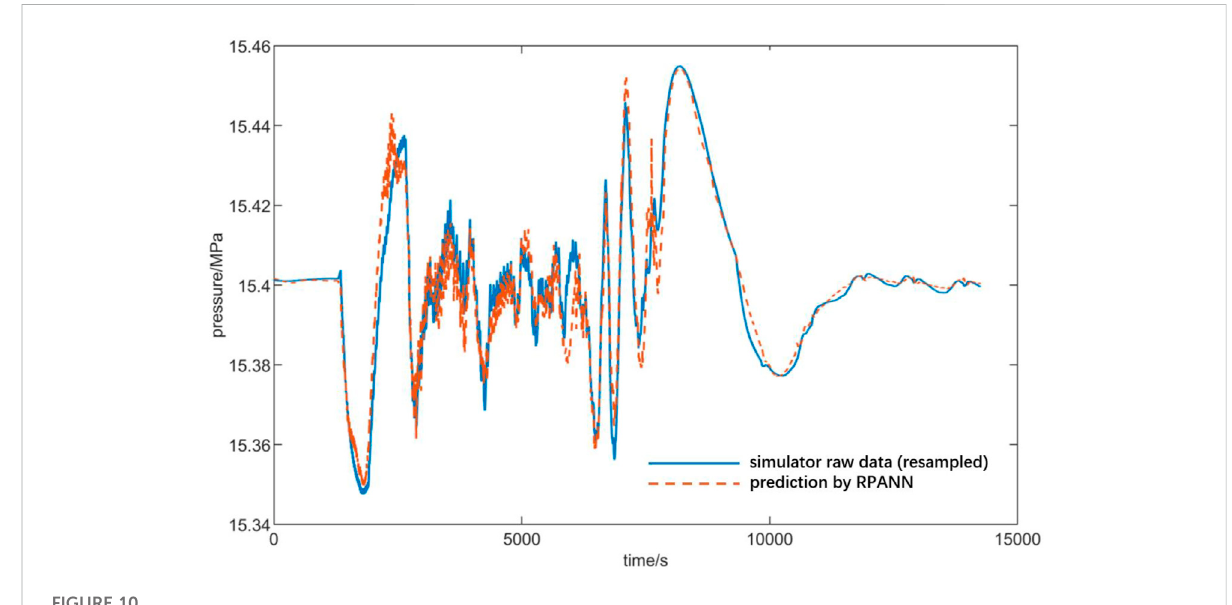
FIGURE 10 Veri fi cation of the generalization ability of the RPANN.